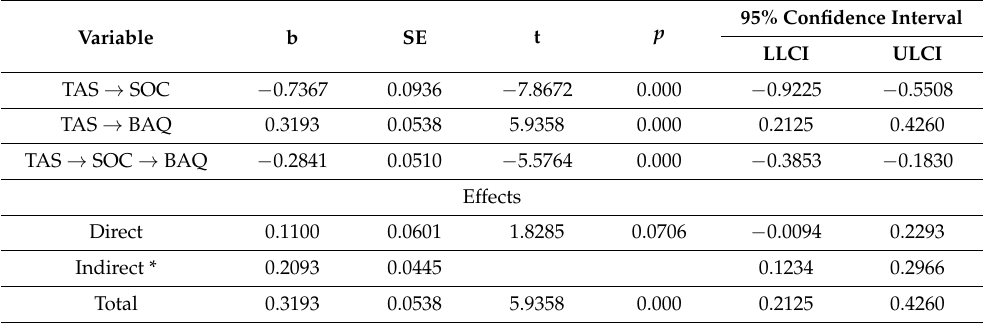
Table 6. Mediation analysis of sense of coherence (SOC) on Toronto alexithymia scale (TAS) – brief aggression questionnaire (BAQ) relationship.